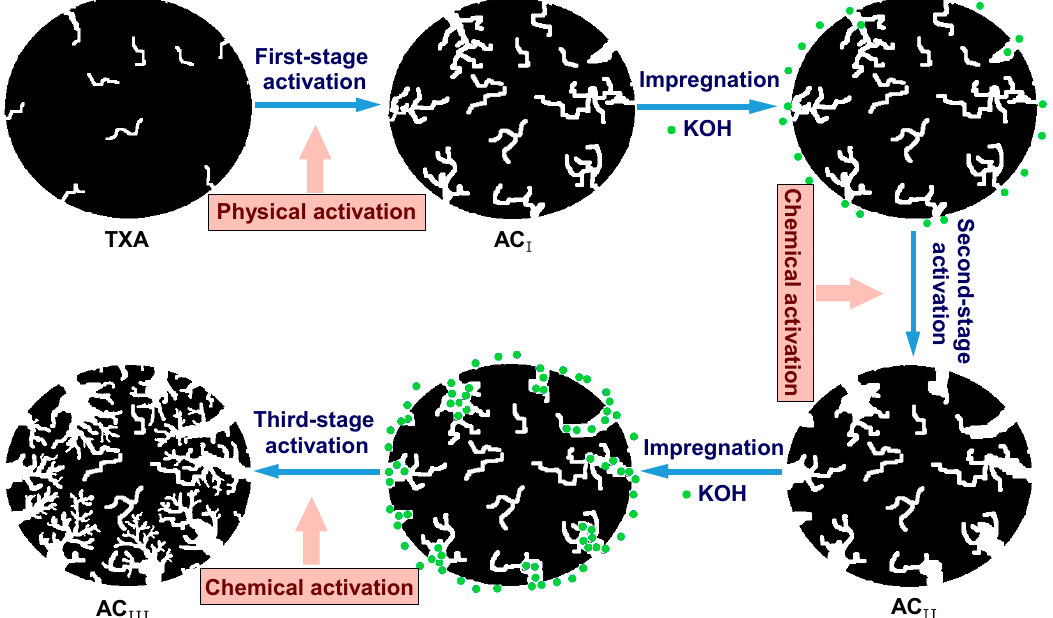
Molecules 2019 , 24 , x FOR PEER REVIEW 7 of 15 Table 1. The pore structure parameters of TXA and